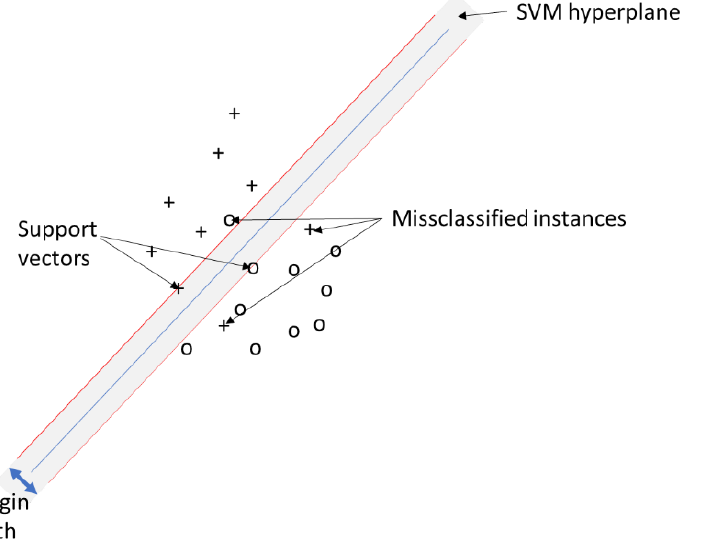
Figure 4. Linear SVM example adapted from [34].